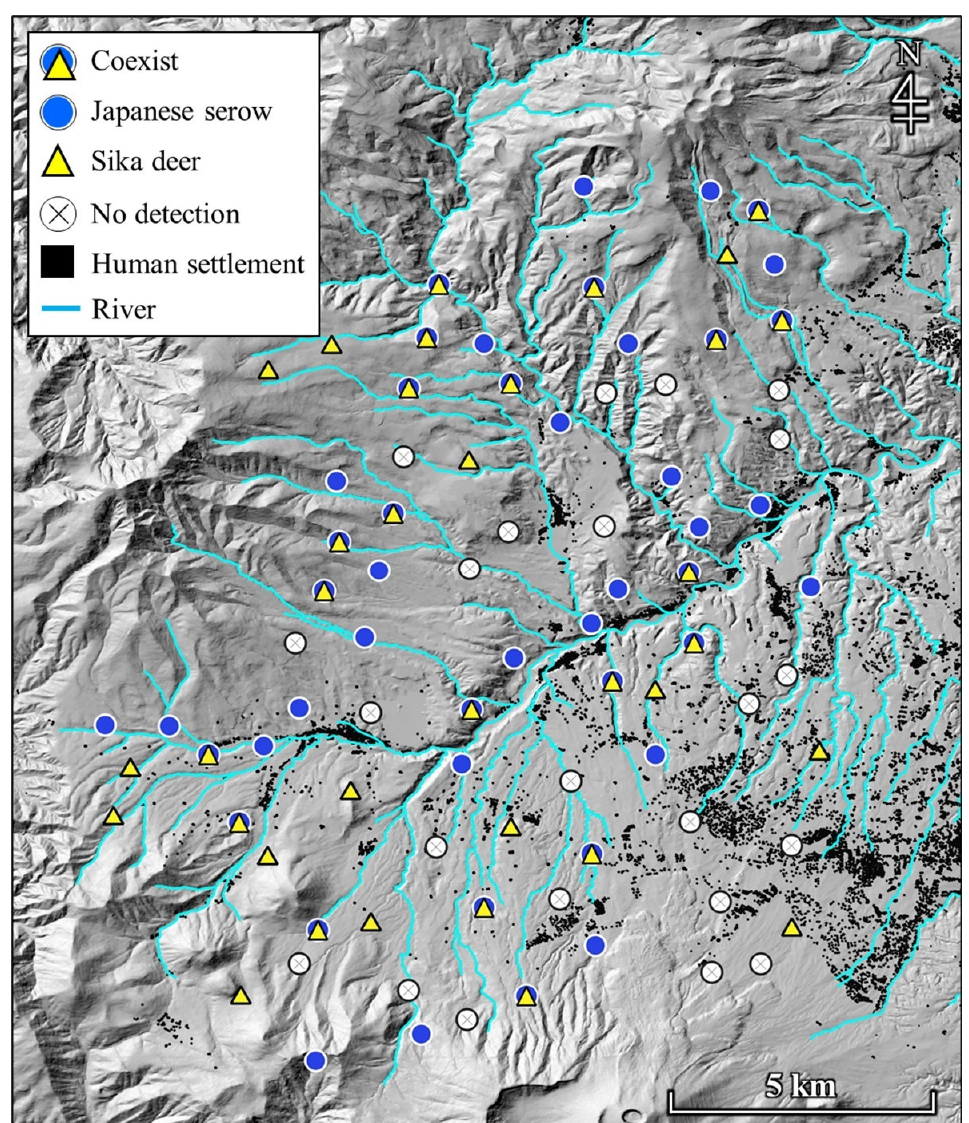
Figure 2. Distribution of Japanese serows and sika deer in Tsumagoi, central Honshu, Japan. Circles and triangles in the figure represent the sites where either Japanese serows or sika deer were photographed by camera traps, respectively. The map was created based on national land and base map information from the Ministry of Land, Infrastructure, Transport and Tourism of Japan.